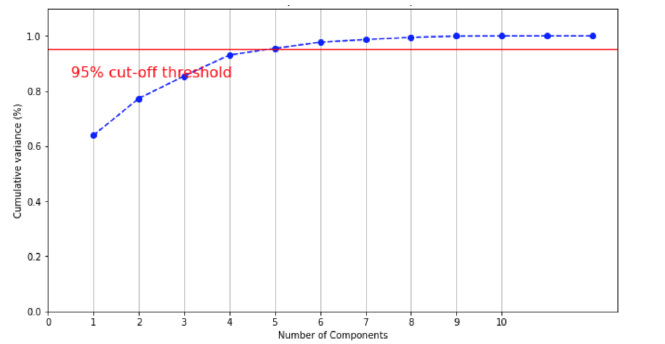
Figure 6. The number of components needed to explain 95% variance.